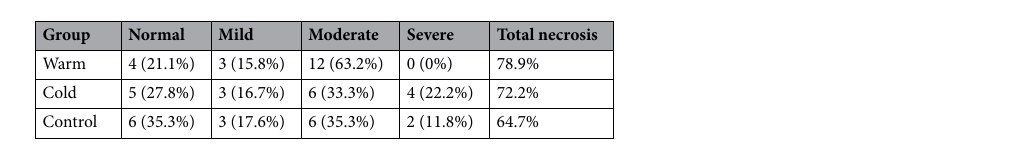
Table 2. Tissue necrosis 7 days after intravascular